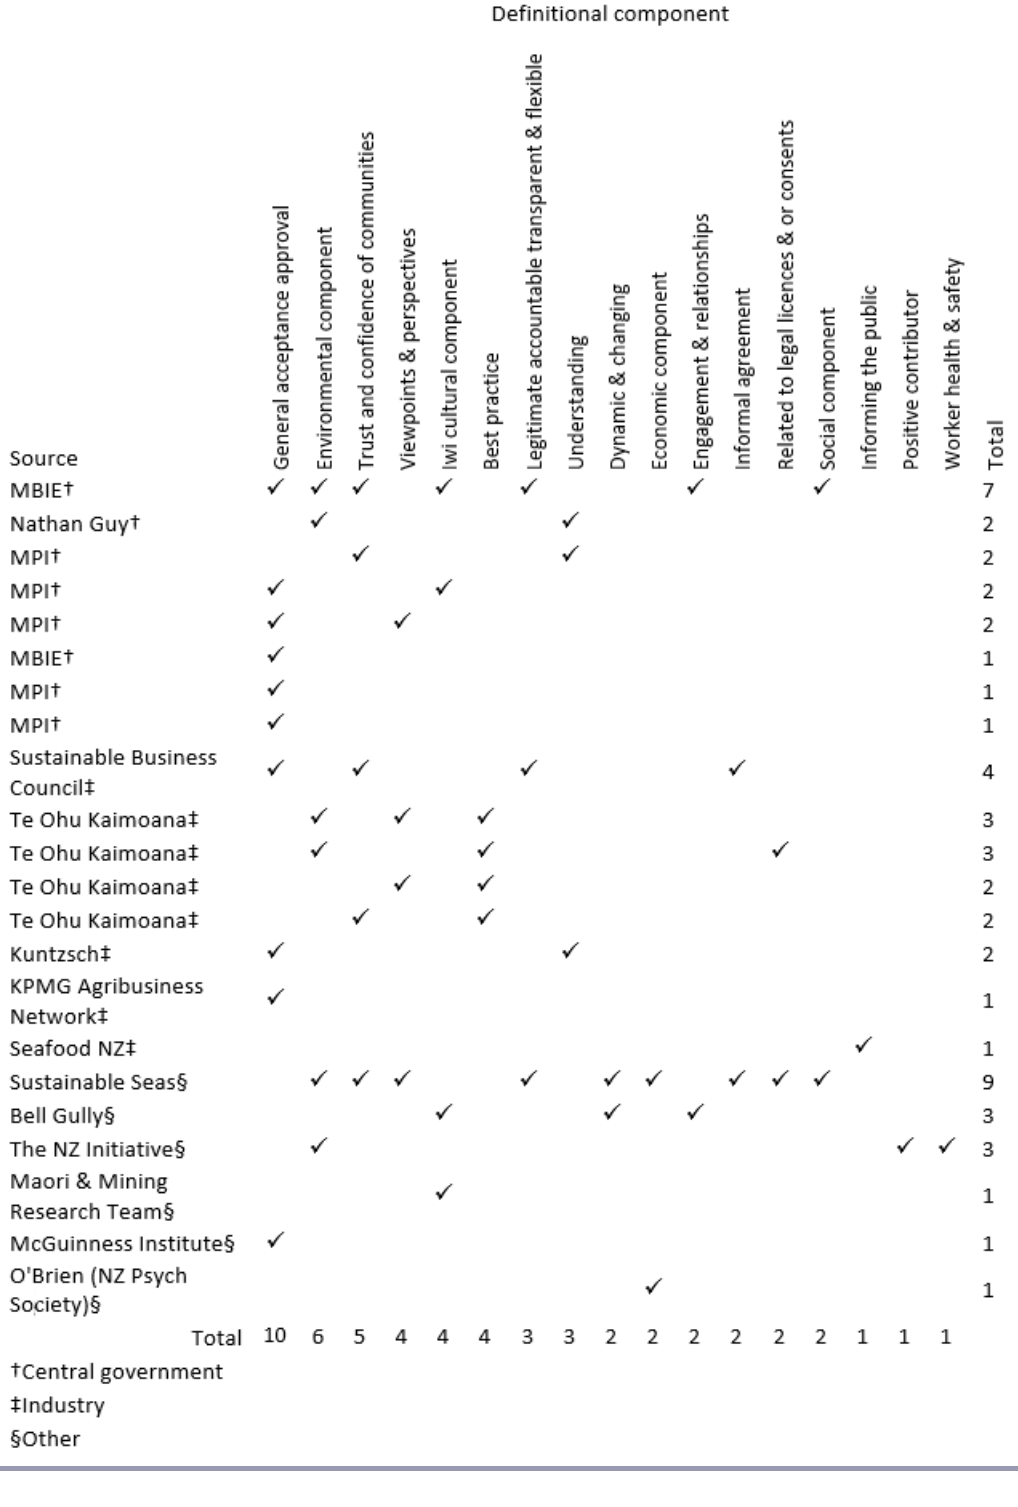
Fig. 3 . Definitional components of social license to operate (SLO) by source. Iwi = Indigenous M ā ori tribes of New Zealand; MBIE = Ministry for Business, Innovation, & Employment; MPI = Ministry for Primary